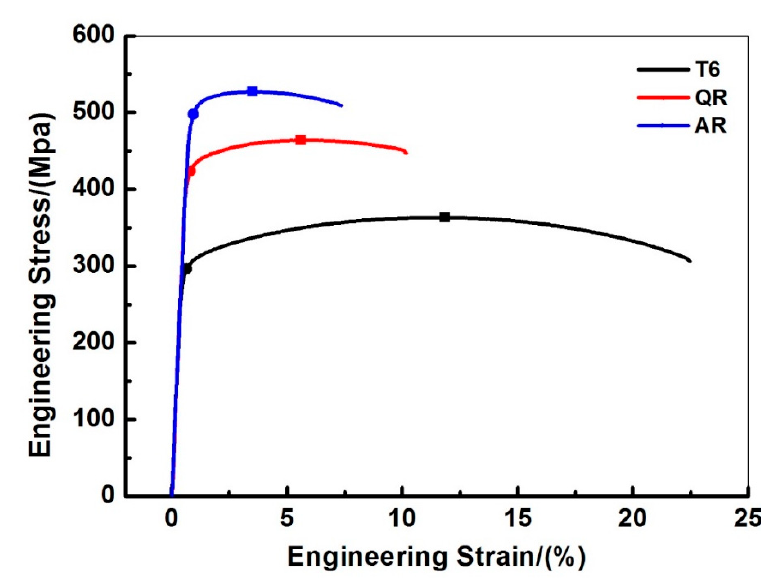
Figure 1. The stress-stain curves of samples subjected to T6 treatment or thermos-mechanical processing (AR and QR).